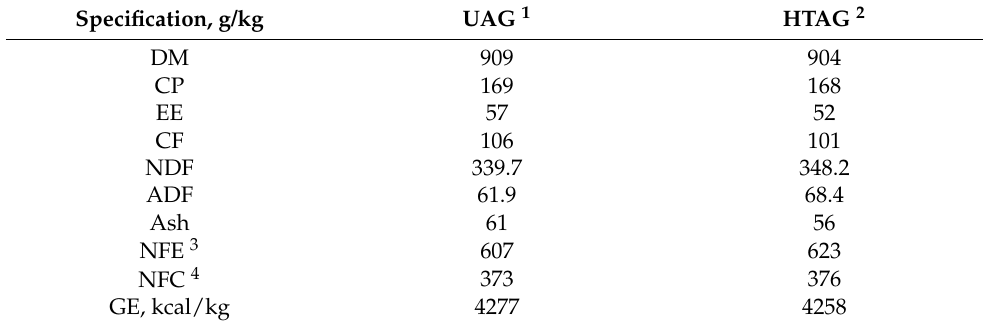
Table 2. Chemical compositions of amaranth grains ( A. hybridus chlorostachys ) on an as-fed basis. Specification,